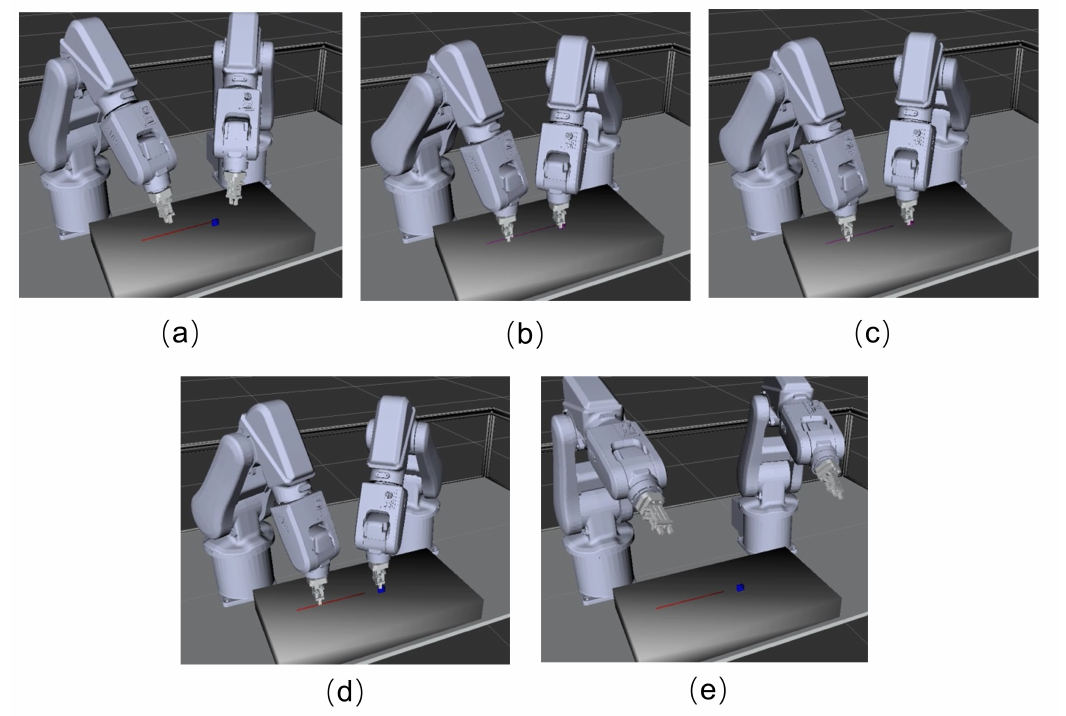
Figure 15. Task simulation in RViz. ( a ) Dual-robot approaches grasping points. ( b ) Dual-robot grabs object. ( c ) Left robot pulls out the wire. ( d ) Dual-robot puts down the object. ( e ) Dual-robot returns to the origin.